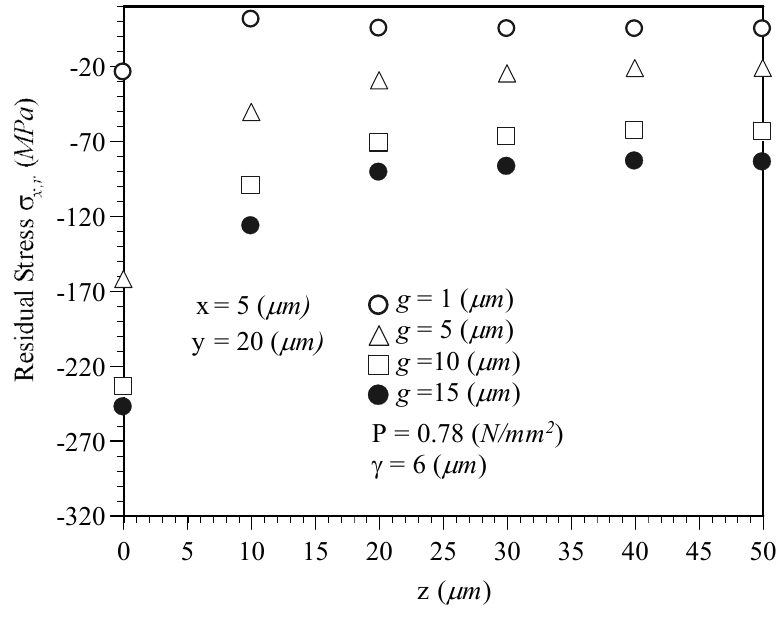
Figure 7. Residual stress σ distribution on the top surface x,r of the microcantilever beam along the z-axis for various film